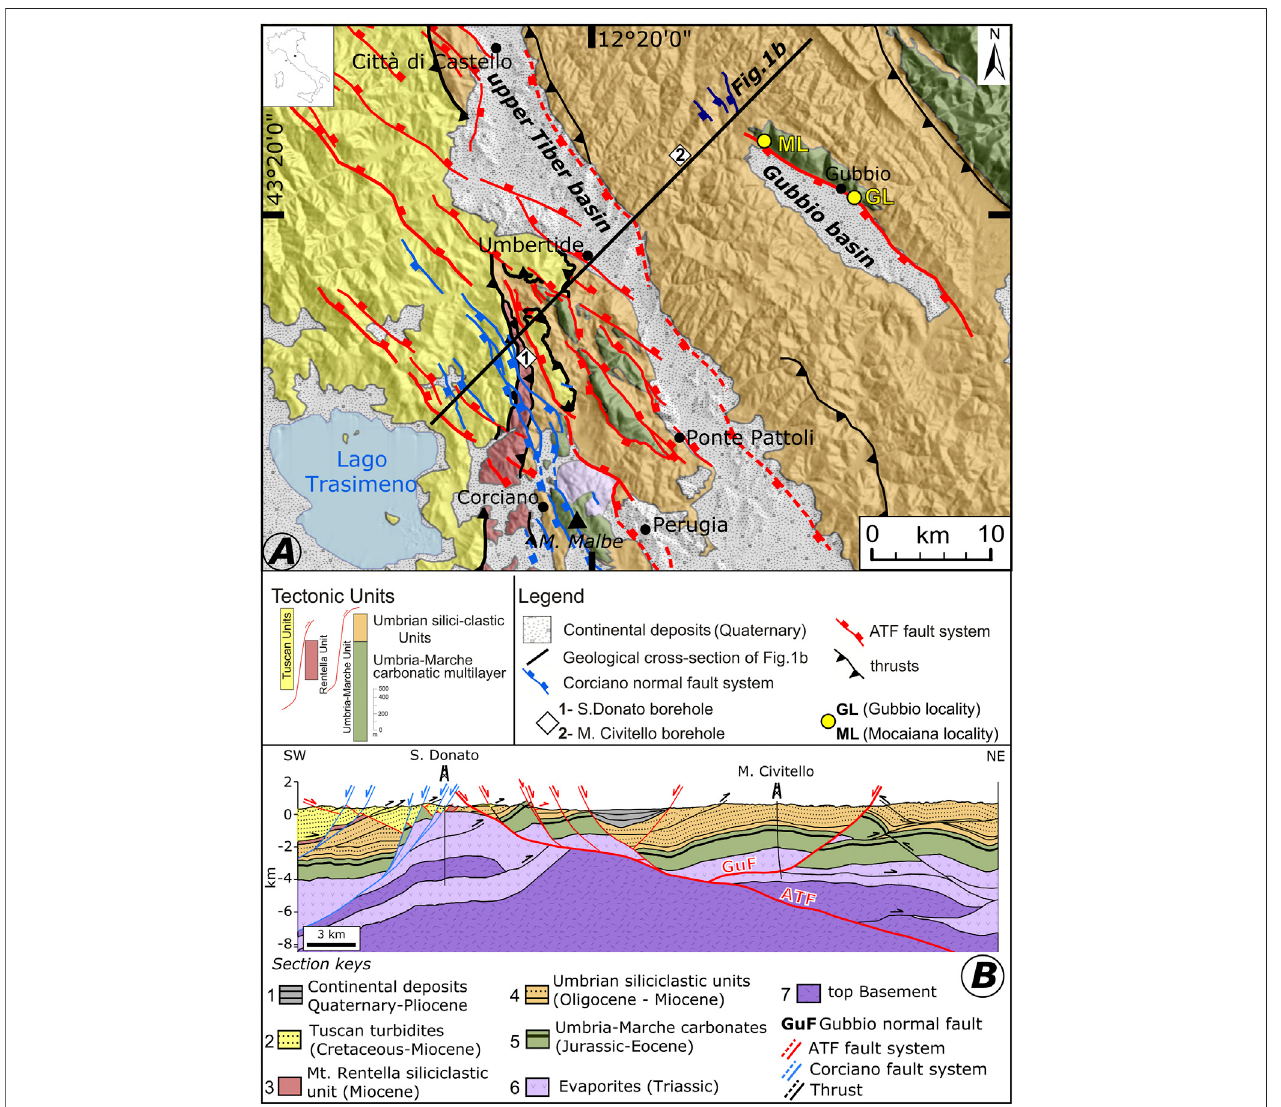
FIGURE1| Geologicmap (A) andcrosssection (B) ofthestudyarea.A)Fieldlocationsaremarkedbyayellowcircle.RelativetothetownofGubbio,theMocaiana locality (ML) is to the northwest, the Gubbio locality (GL) is to the southeast. B) The ATF and associated epidetachment faults are denoted in red, while the eastern Corciano fault system is in blue. Modi fi ed from Mirabella et al. (2011).